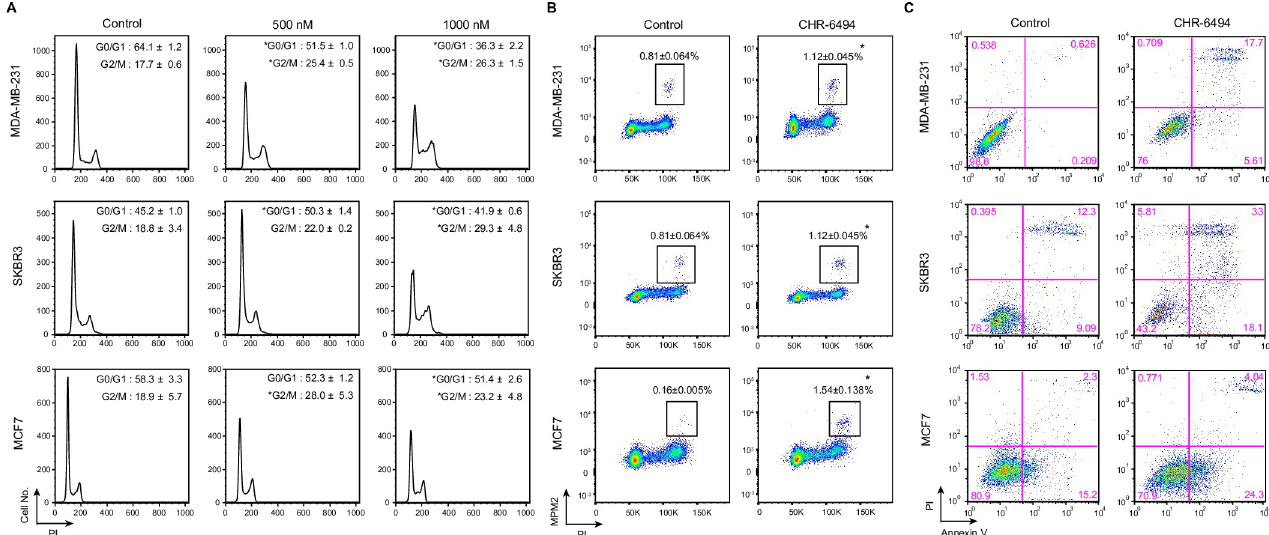
Fig 3. CHR-6494 induces cell cycle arrest and apoptosis in vitro . (A, B) Flow cytometry analysis of control and CHR-6494-treated breast cancer cells. DNA profiles (A) and phospho-MPM-2 profiles (B). Black boxes indicate the gated mitotic cell populations (B). (C) Dot plots showing the distributions of FITC-Annexin V/PI-stained control and CHR-6494-treated breast cancer cells. The cells in the lower left quadrant represent viable cells (FITC-Annexin V/PI- negative). The cells in the upper and lower right quadrants represent the late and early apoptotic cells, respectively. Data are presented as means ± SD of three independent experiments. � P < 0.05 (Student’s t